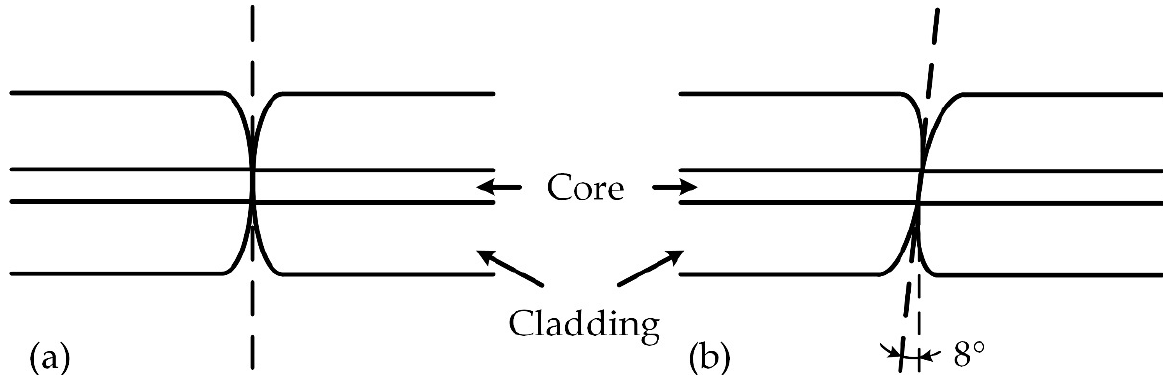
Figure 9. Schematic view of butt-jointing optical connection: ( a ) the fiber end-faces of UPC connectors are processed into a slightly convex shape, and ( b ) the fiber end-faces of APC connectors have an angled shape with standard 8°.